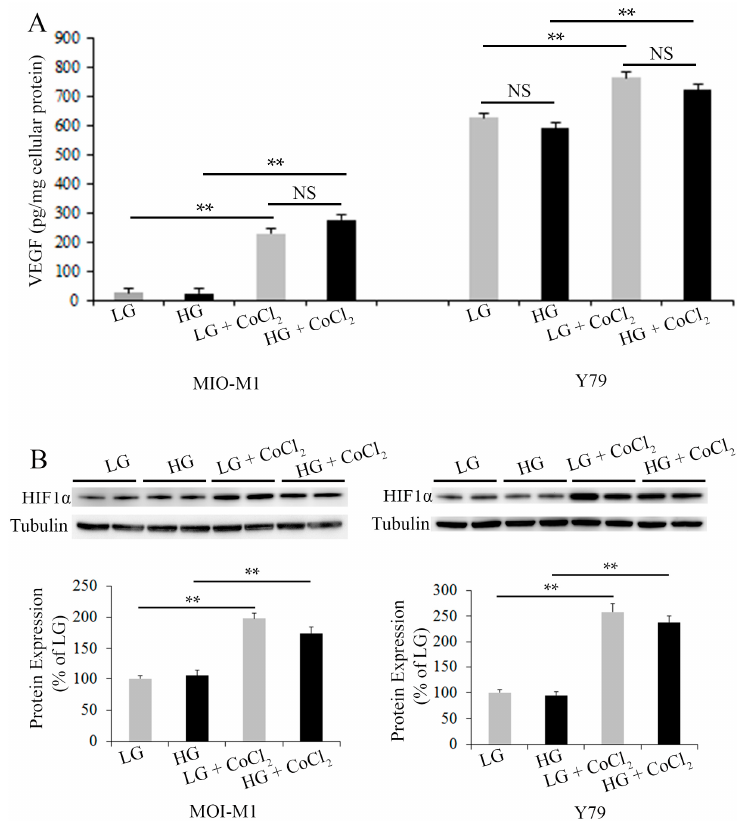
Figure 2. Effects of cell stress on VEGF-A and HIF1 α expression in Müller cells and Y79 photoreceptors. ( A ) VEGF-A was measured by ELISA using conditioned media collected from MIO-M1 and Y79 cells, n = 4–5/group in Müller cells and n = 8/group in Y79 photoreceptors, ** p < 0.01; ( B ) Western blots for HIF1 α using cellular proteins, n = 4/group, ** p < 0.01. For MIO-M1 Müller cells: Grey bars: 5 mM glucose. Black bars: 25 mM glucose. For Y79 photoreceptors: Grey bars: 11 mM glucose. Black bars: 25 mM glucose. NS, not significant; LG, low glucose; HG, high glucose.